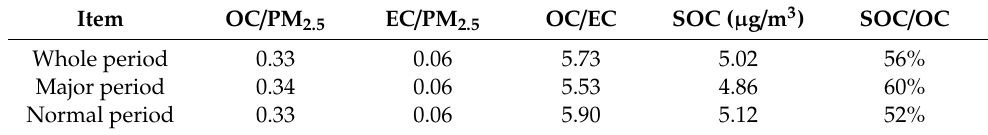
Table 2. The proportional relationship between PM 2.5 , OC, EC, and SOC in di ff erent periods.